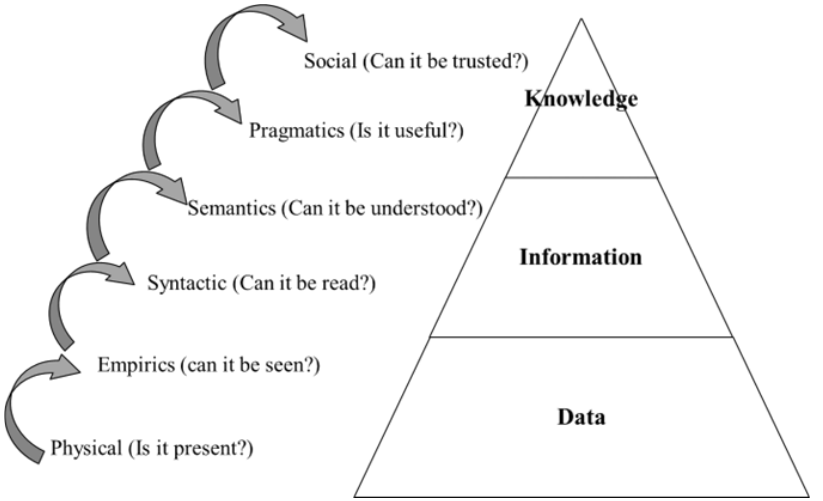
Figure 2. Semiotic levels and the data-information-knowledge hierarchy, adapted from [32]. 2018, Huang.